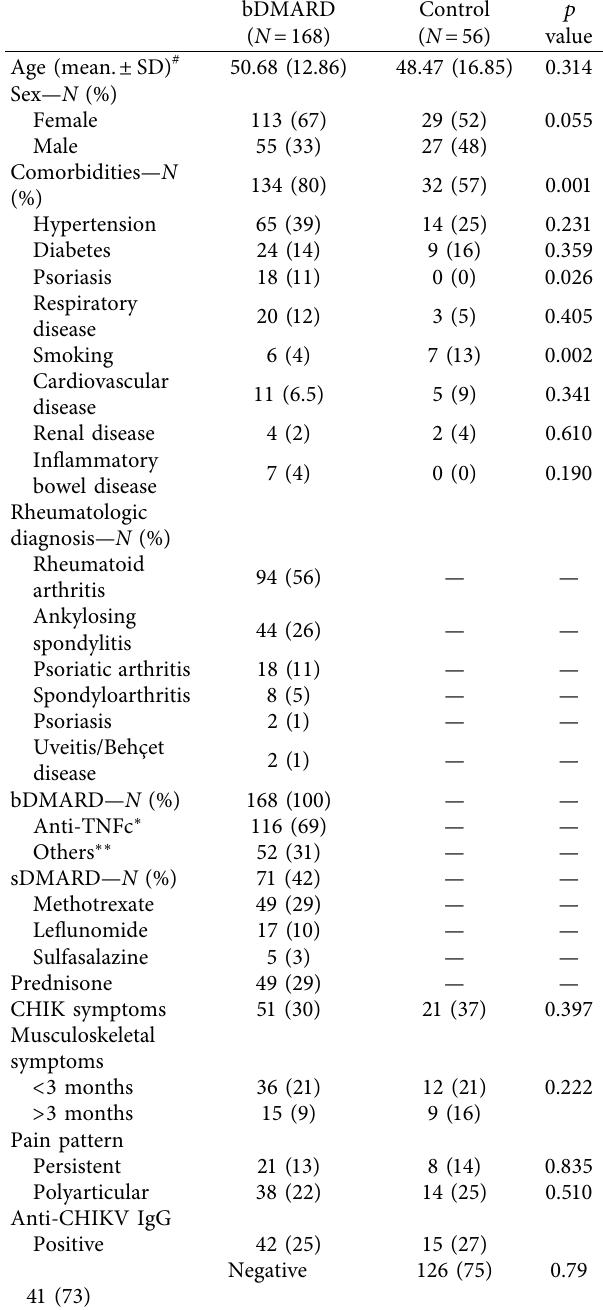
Table 1: Clinical and demographic data comparing the group with rheumatologic disease using bDMARDs and the control